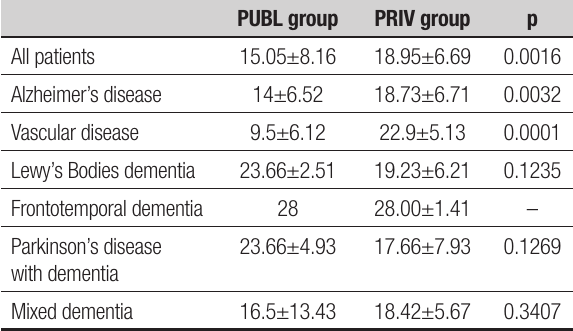
Table 3. Mean MMSE* scores at time of admission to